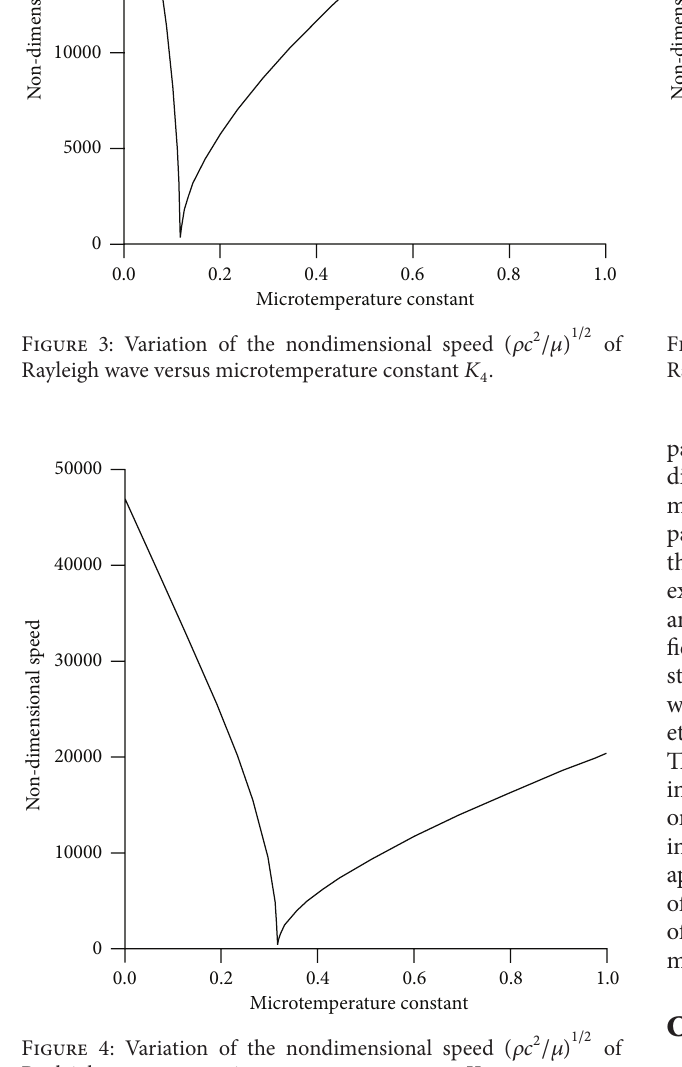
Figure 4: Variation of the nondimensional speed (𝜌𝑐 2 /𝜇) Rayleigh wave versus microtemperature constant 𝐾 5 .